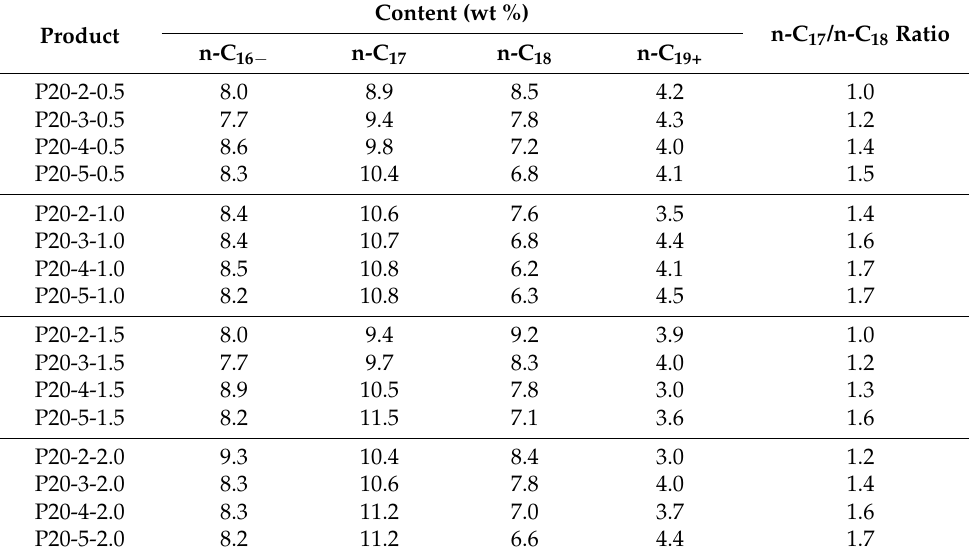
Table 6. The content of n-alkanes in P20 liquid products.